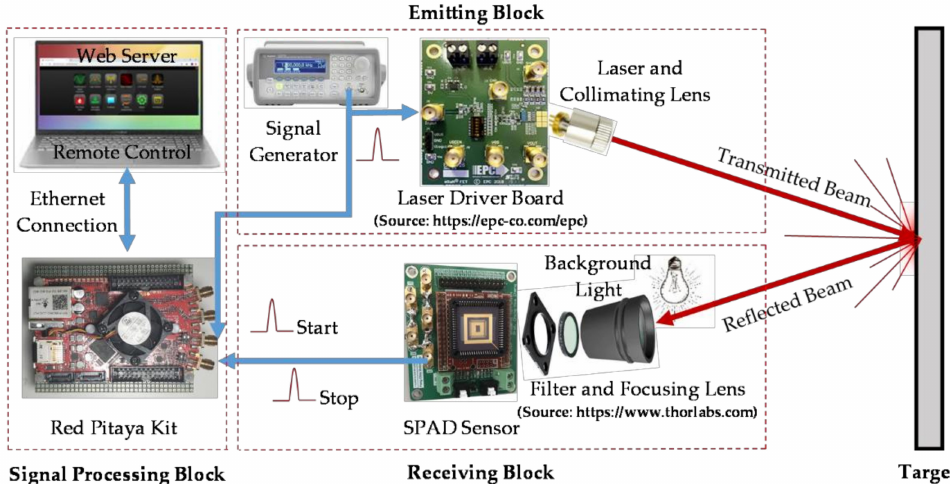
Figure 1. Hardware block